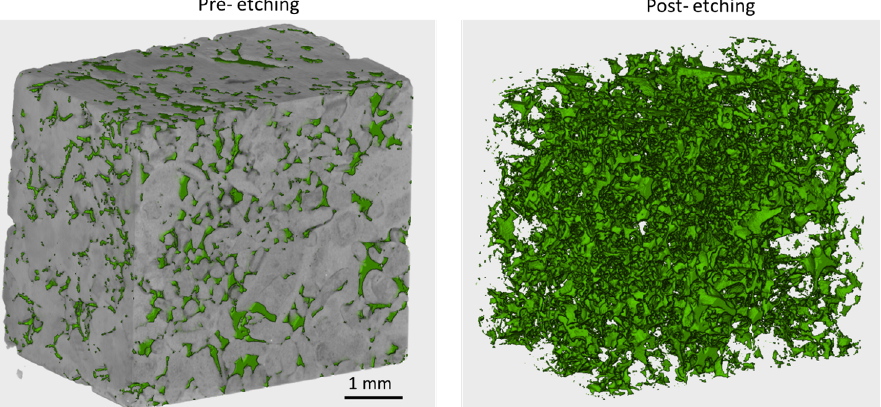
Figure 14. Two micro-CT scans of resin impregnated sample pre-etching ( left ) and post-etching ( right ) the rock matrix with hydrochloric acid. Color coding based on threshold segmentation was used to identify rock matrix (grey), and resin (green).